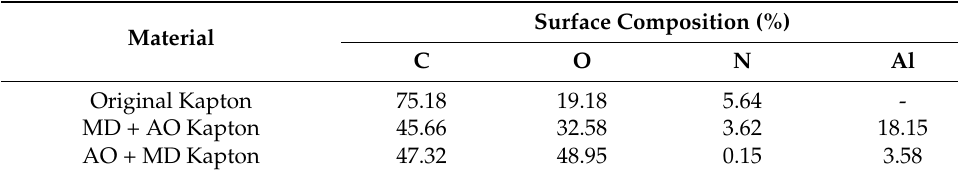
Figure 12. Reaction mechanism diagram of Kapton film MD + AO and AO + MD load spectrum. Table 1. Relative content of surface elements after original Kapton film and MD + AO, AO + MD load spectrum